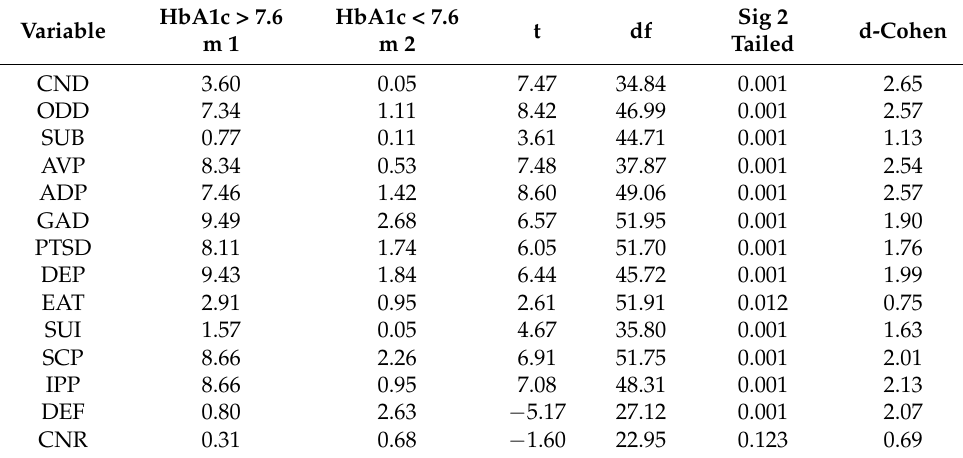
The correlation between HbA1c value and the variables constituted by APS–SF sub- scales was determined using the Spearman’s test, which demonstrated the existence of a strong positive correlation ( p = 0.001) between almost all the subscales and HbA1c